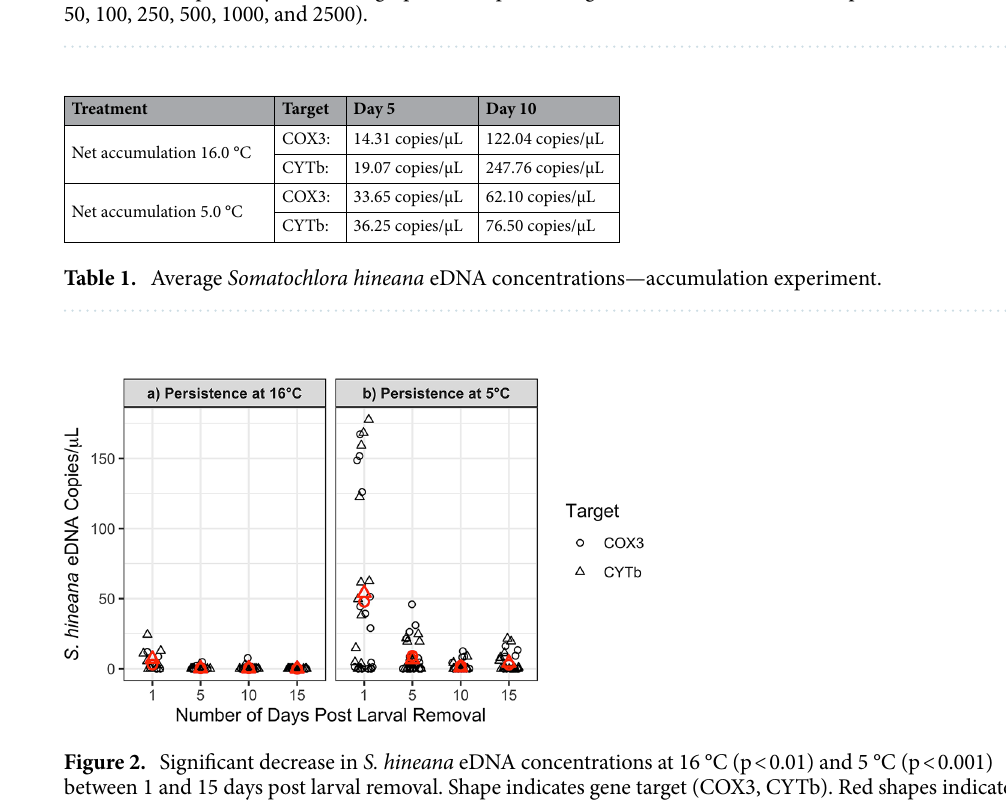
Figure 1. Significant accumulation (p < 0.001) in S. hineana eDNA concentrations at 16 °C between 5 and 10 days post water change. No significant change in S. hineana eDNA concentrations at 5 °C between 5 and 10 days post water change (p = 0.37). Shape indicates gene target (COX3, CYTb). Black shapes indicate average quantification for each target. Red, green, and blue shapes indicate quantifications for large, medium, and small size classes, respectively. Points are graphed on a pseudo-log scale (0.1–2500) with break points at (0, 1, 10, 25, 50, 100, 250, 500, 1000, and 2500).